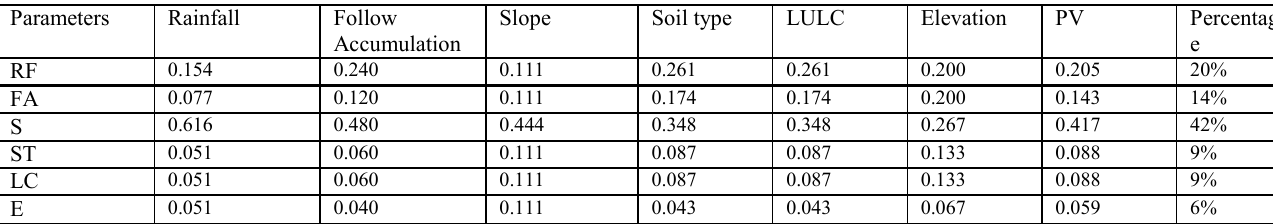
Table 7: Normalized flood hazard parameters: Analytical Hierarchy Process